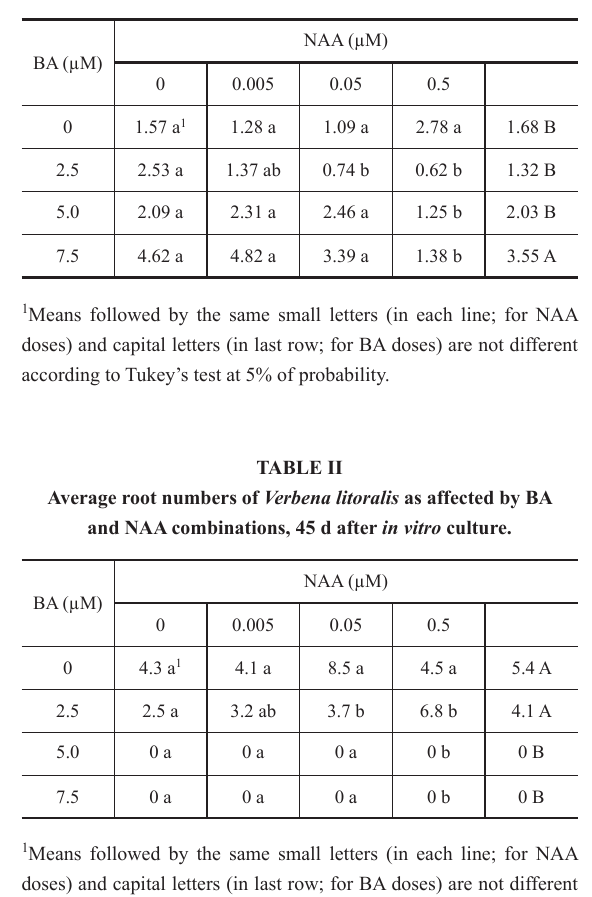
Average shoot numbers of Verbena litoralis as affected by BA and NAA combinations, 45 d after in vitro culture.